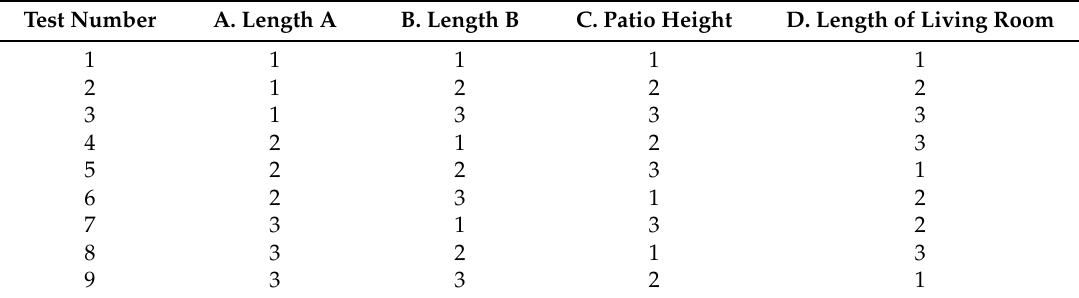
Table 3. L 9 (3 4 ) Orthogonal experimental table.